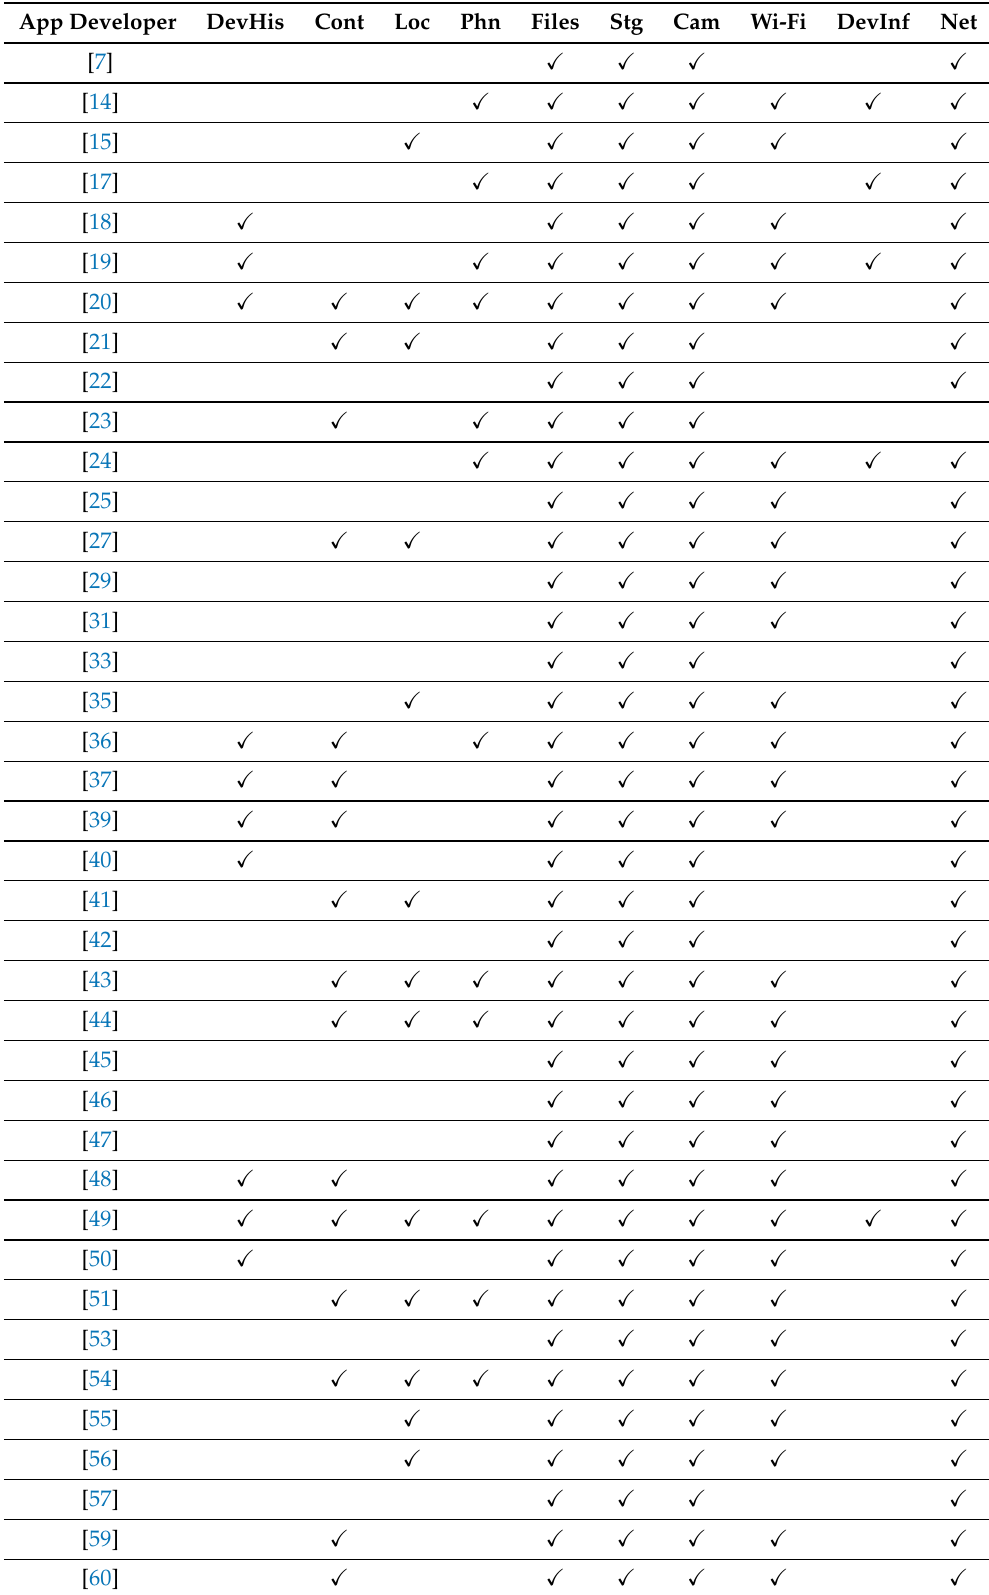
Table 5. Permissions of Tested QR Code Readers. App